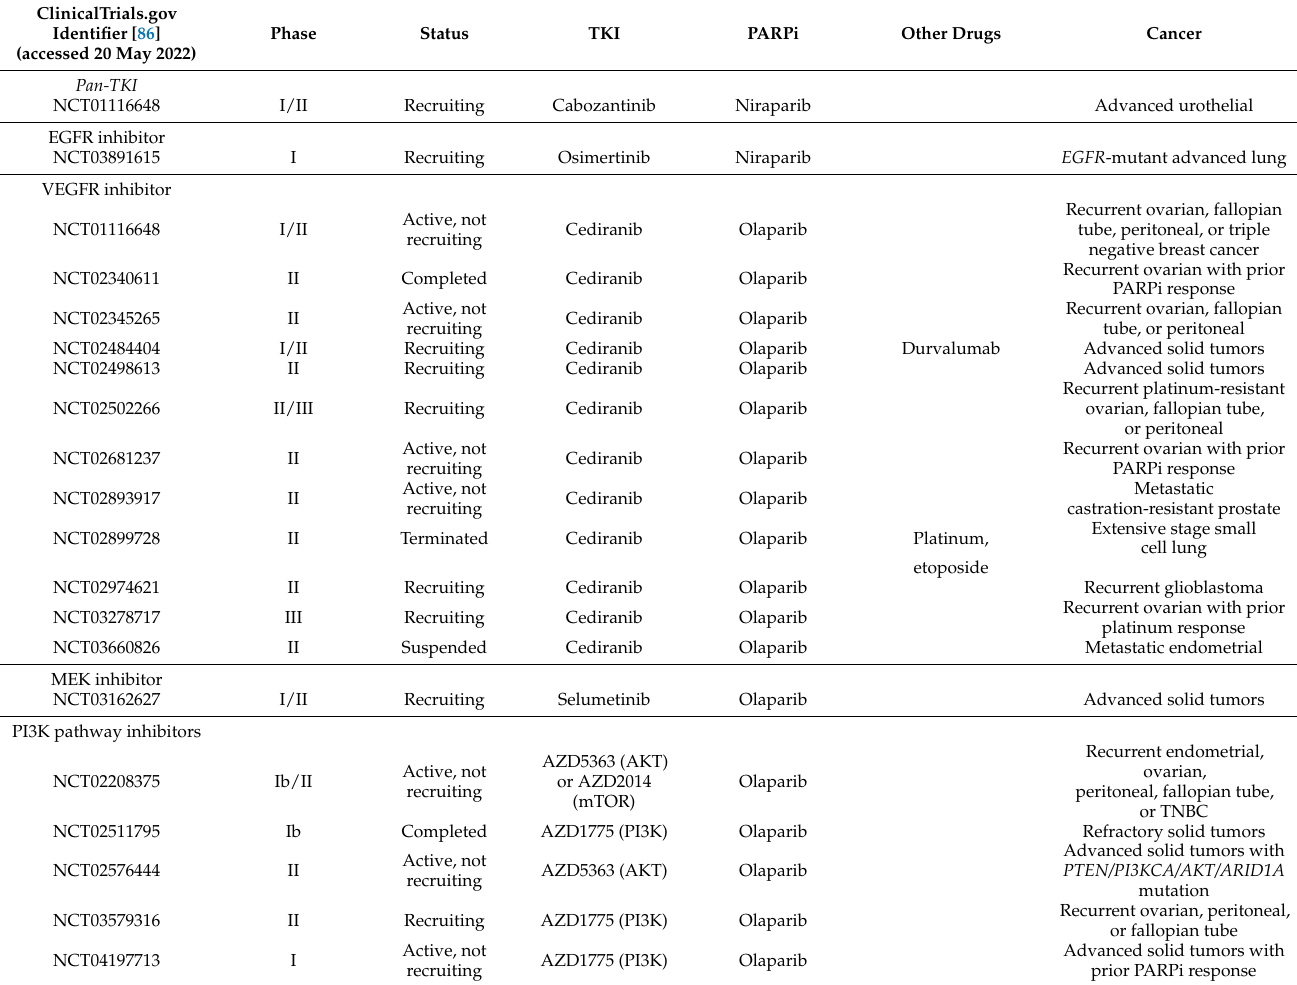
Table 3. Clinical trials evaluating TKI in combination with